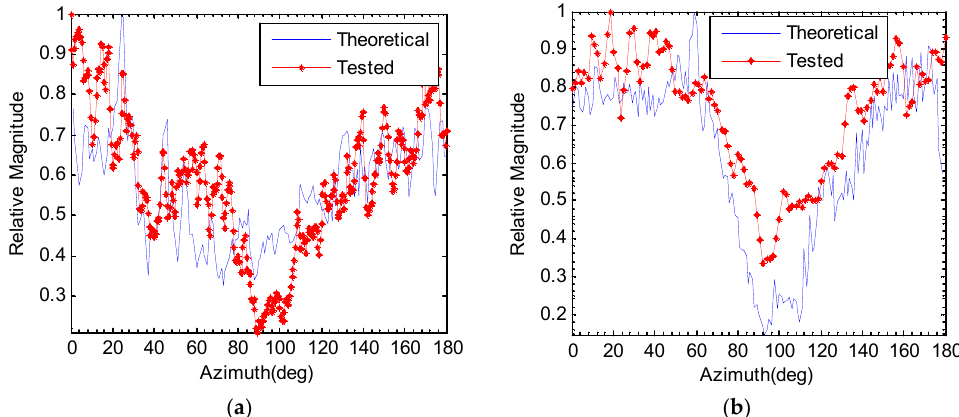
Figure 11. STD of theoretical and tested echo envelope fluctuation intensity with the frequency of LFM 20–40 kHz. ( a ) The pulse length is 1 ms; ( b ) the pulse length is 3 ms. Figure 12 is the STD results of fluctuation intensity of the scaled benchmark model, varying with